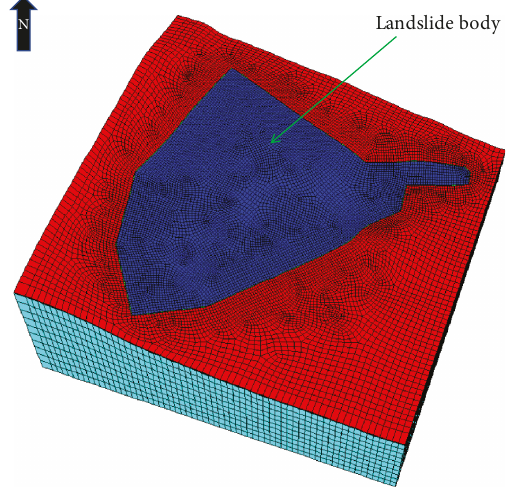
Figure 16: 3D numerical model of Dasha landslide.